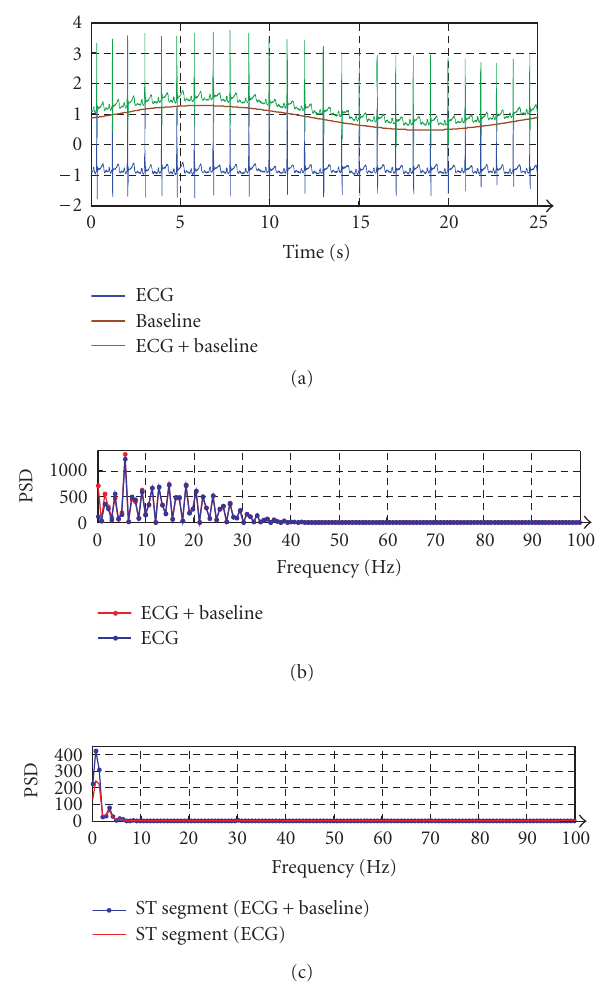
Figure 13: (a) 25 seconds of sine-wave plus clean ECG highlighted, (b) power spectrum density of the signal, (c) power spectrum den- sity of ST-segments of the signal.